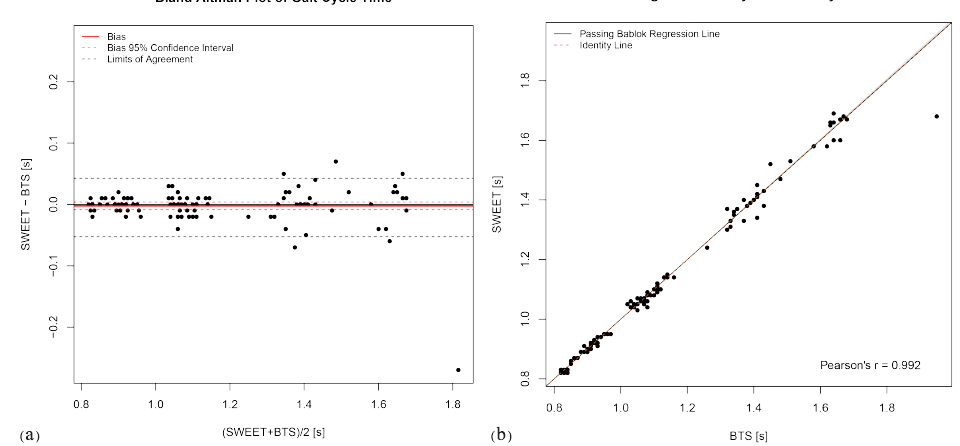
Figure 6. Gait cycle time: ( a ) Bland–Altman plot; ( b ) Passing–Bablok regression